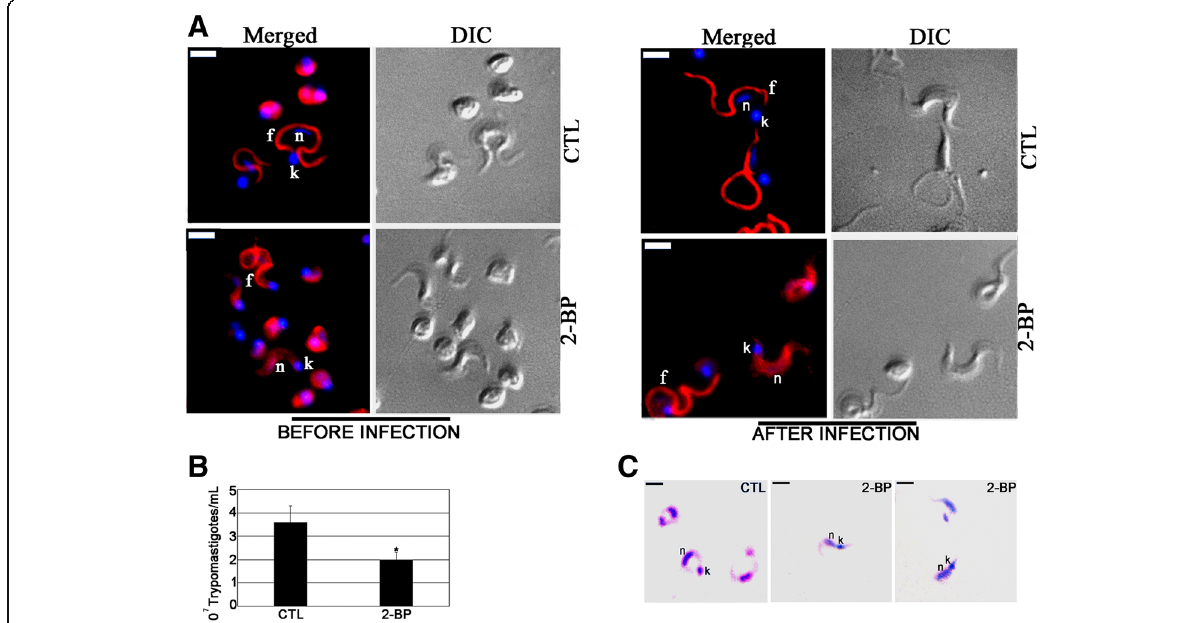
Fig. 9 2-BP treatment of culture trypomastigotes with IC 50 2-BP alters Trypanosoma cruzi host cell infectivity. a 2-BP treatment before infection altered TcFCaBP flagellar localization in parasites obtained before and after infection. b Note the decrease in number of released trypomastigotes four days after infection. *: p > 0.05 ( c ) Giemsa staining of released trypomastigotes showing morphological alterations. n: nucleus; k: kinetoplast. Bars = 5 μ